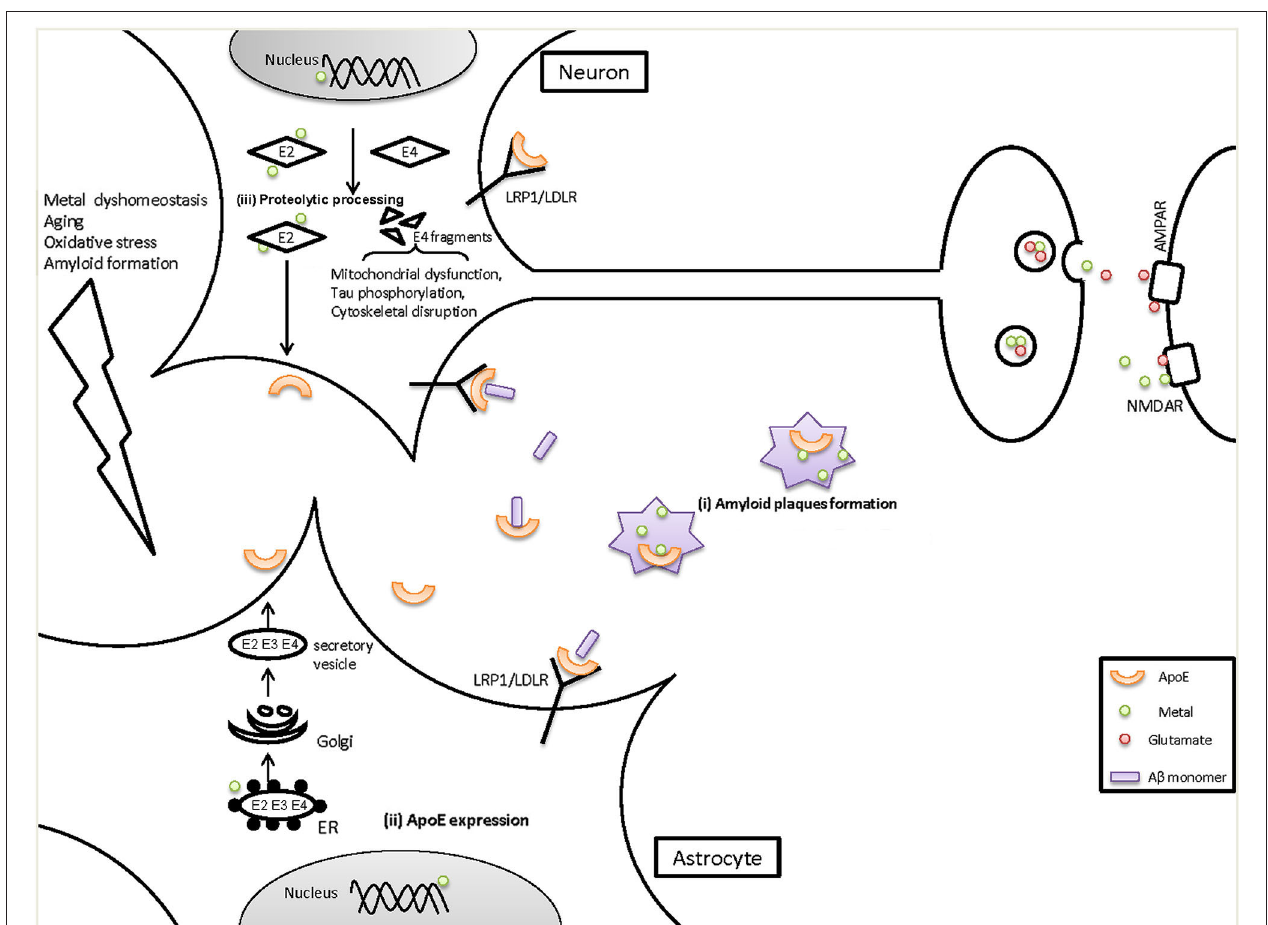
zinc and glutamate levels at synapse. (iii) In response to aging, Oxidative stress and amyloid formation, neurons turn on or increase their expression of ApoE. However, neuron-ApoE is cleaved and generate C-terminal truncated fragments. ApoE4 is much more susceptible than ApoE2 and ApoE3. In the proteolysis of ApoE, metals bind to ApoE2 and stabilize its intact structure whereas ApoE4, which has a decreased affinity for metals, tends to be degraded to fragments. ApoE4 fragments can induce severe impairments to mitochondrial function and to the cytoskeleton, leading to neurodegeneration. Additionally, more ApoE2 is secreted in the brain compared with ApoE4, which will then impact various brain functions such as maintaining the normal levels of synaptic zinc and glutamate. In contrast, decreased levels of ApoE4 would reduce their levels and impair hippocampal LTP and then cause cognitive